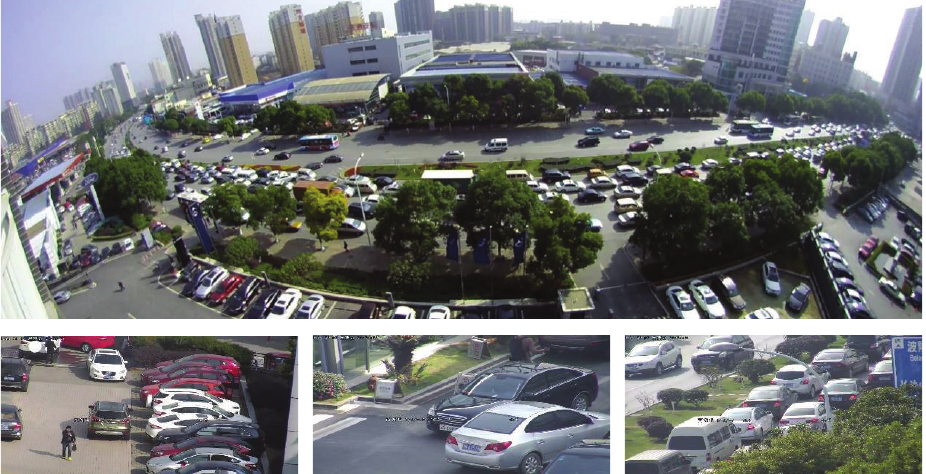
Figure 1: The fish-eye panoramic image captured by the master camera and zoom-in image captured by slave camera with distant details.